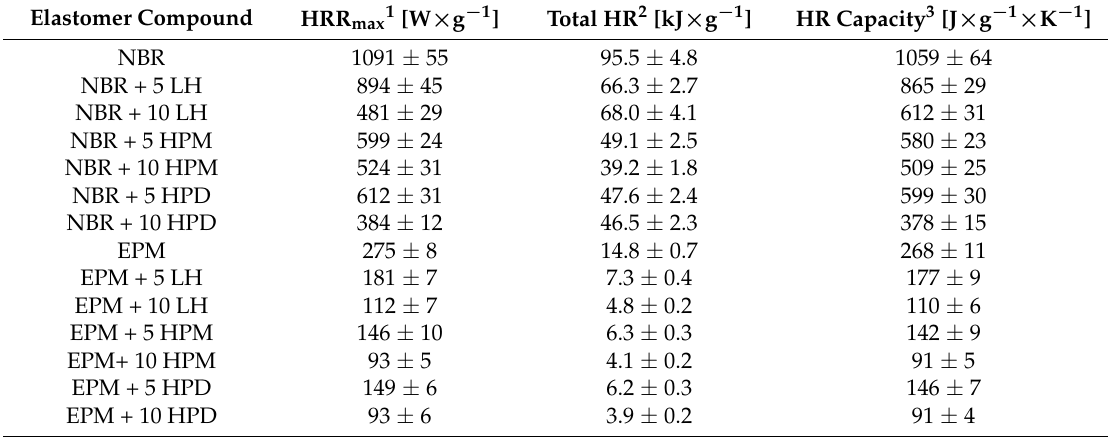
Figure 15. Heat release rate (HRR) curves of ( a ) NBR and ( b ) EPM composites, with a heating rate of 1 K/s. Table 6. The flammability results recorded from the microscale combustion calorimetry (MCC) microcalorimeter.